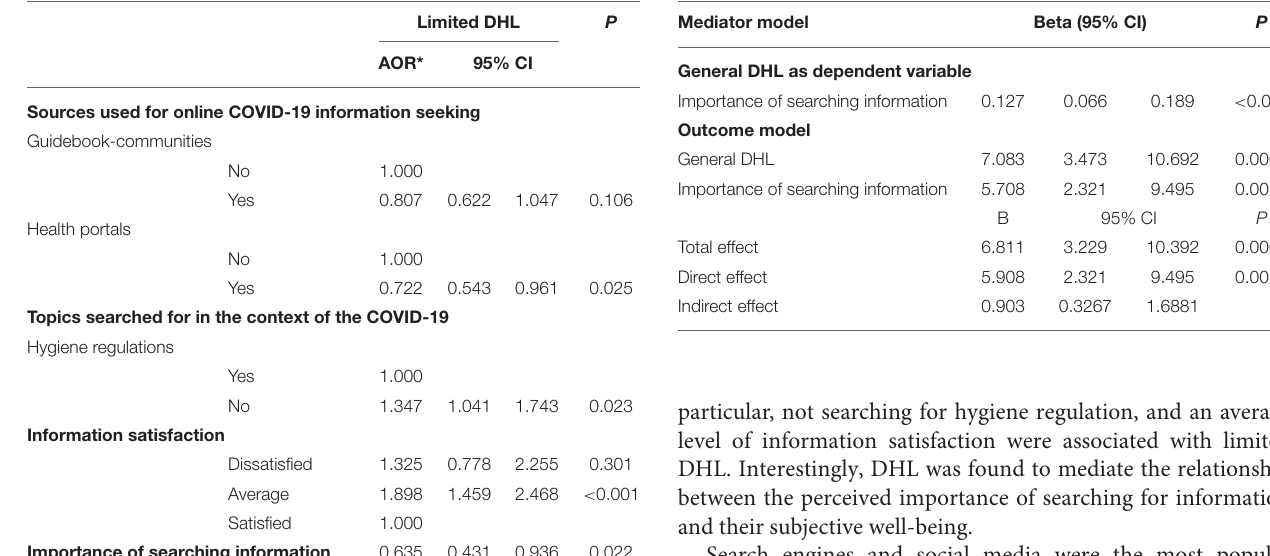
TABLE 3 | Association between DHL and information seeking behavior among Vietnamese university students.